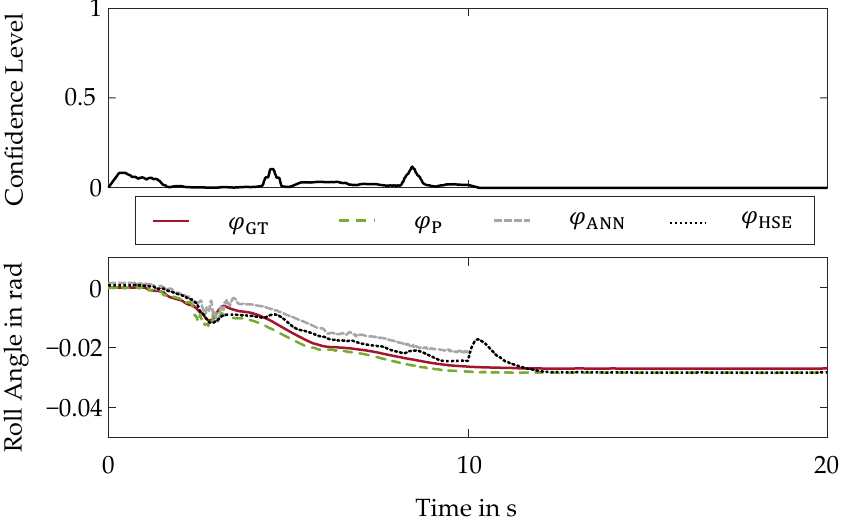
Figure 6. Hybrid Method of State Estimation-Sensor Failure: ( Top ): Confidence Level; ( Bottom ): Roll Angle Curves.